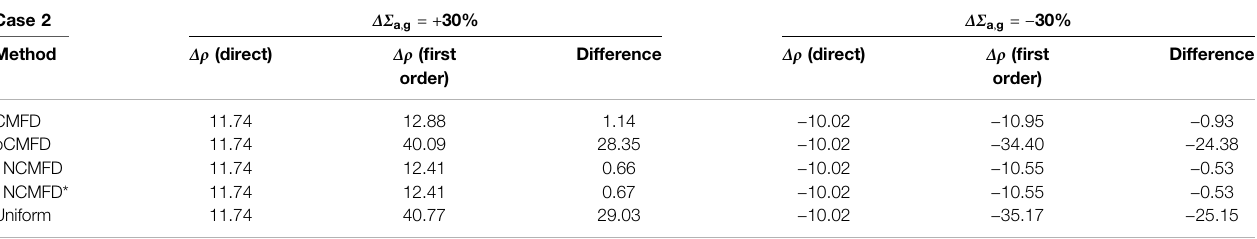
TABLE 6 | Reactivity change (pcm) estimation for perturbation case 2.